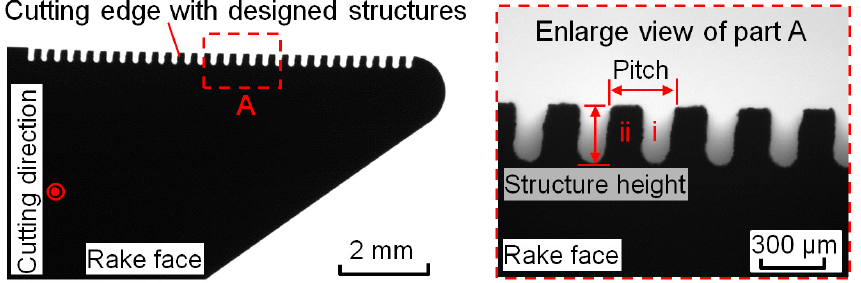
Figure 4. Machined micro structures on tool cutting edge by applying wire cut electrical discharge machining (WEDM).